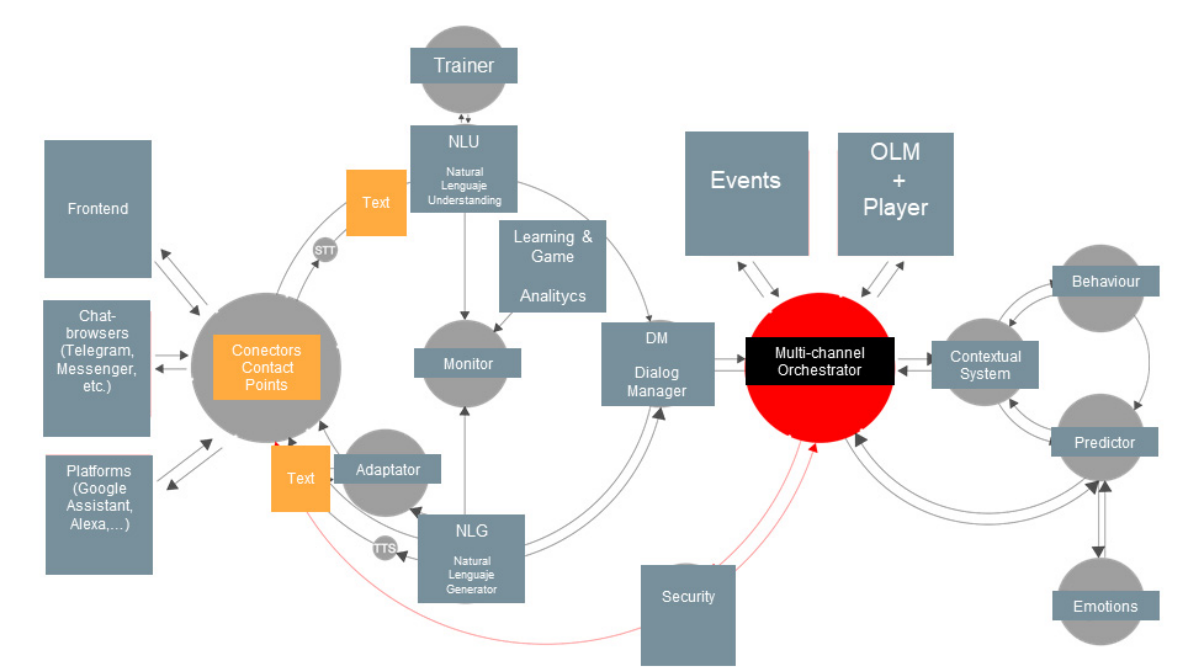
Figure 1. Chatbot Architecture Proposal showing the conversation cycle.